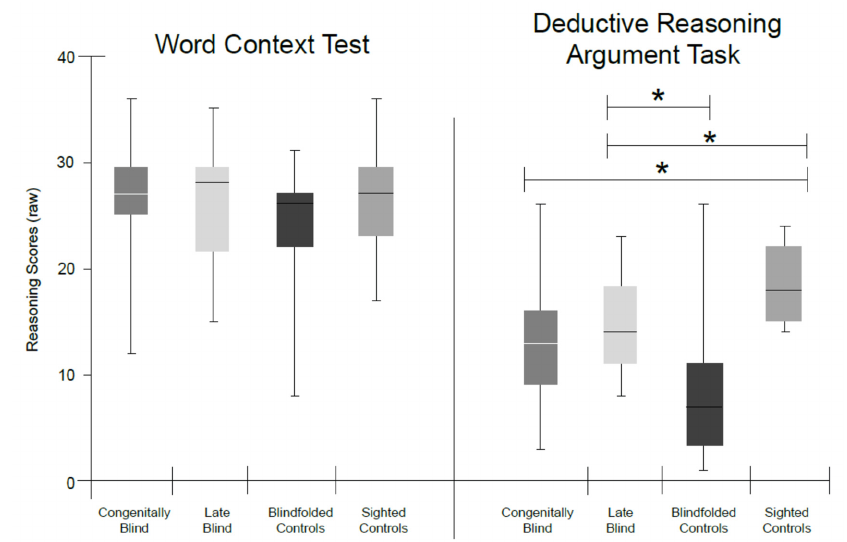
Figure 1. Group comparisons in the reasoning tests scores. Bar graph comparing the performance of congenitally blind, late blind, blindfolded, and sighted controls in the word context test ( left ) and the deductive reasoning argument task ( right ). No difference was found between the groups in the word context test. In the deducting reasoning argument task, the sighted controls performed better than the congenitally blind and blindfolded, and the late blind group performed better than the blindfolded group. * p < 0.05.